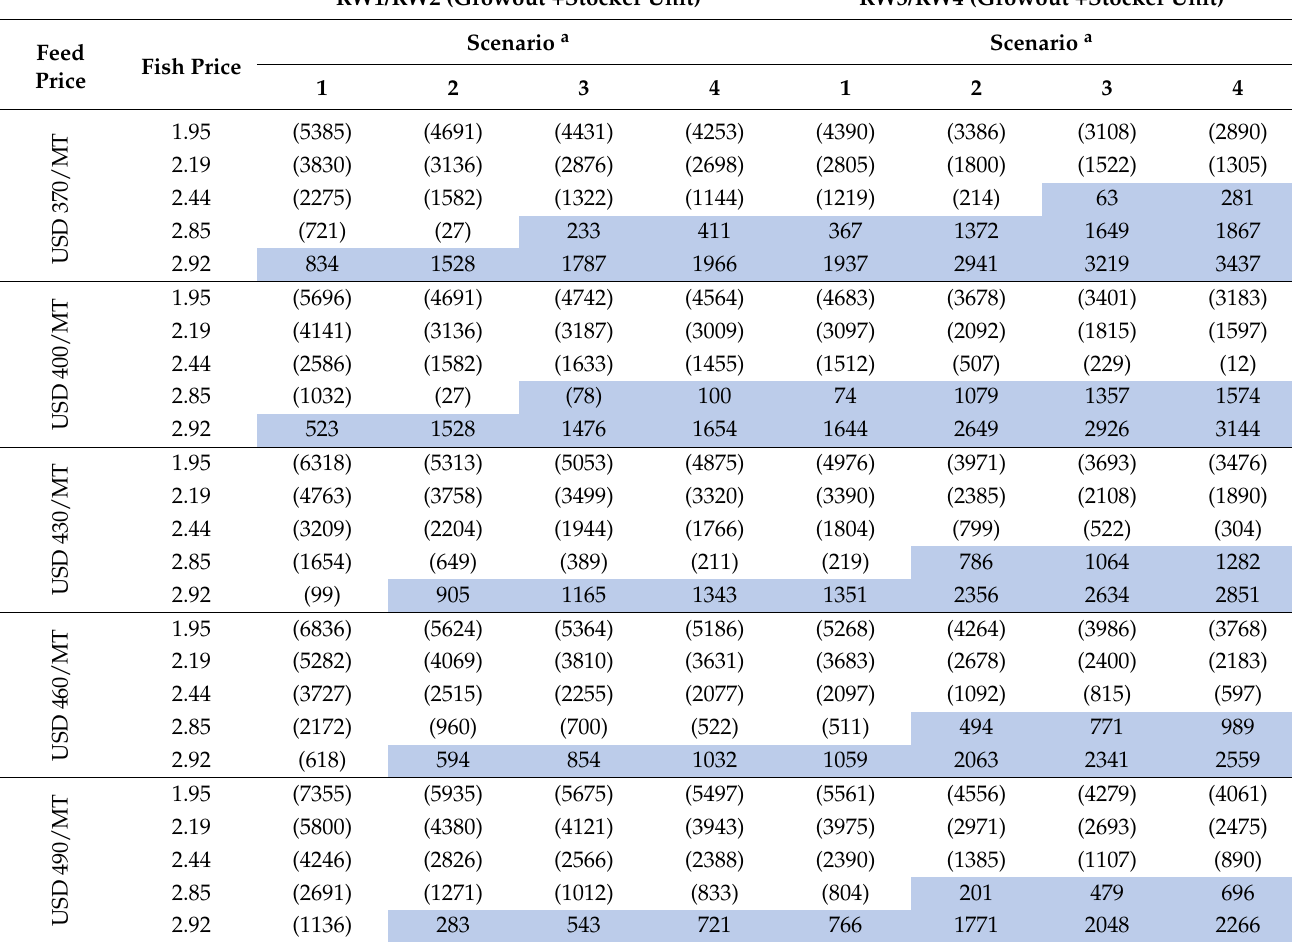
Table 12. Effects of different feed price, fish price, and investment scenarios on net returns required for growout (63 m 3 or 45 m 3 ) plus stocker unit (14 m 3 ) in-pond raceway system (IPRS) from producing hybrid catfish (channel catfish Ictalurus punctatus systems (IPRS), with each raceway placed in a 0.4 ha pond, USD,